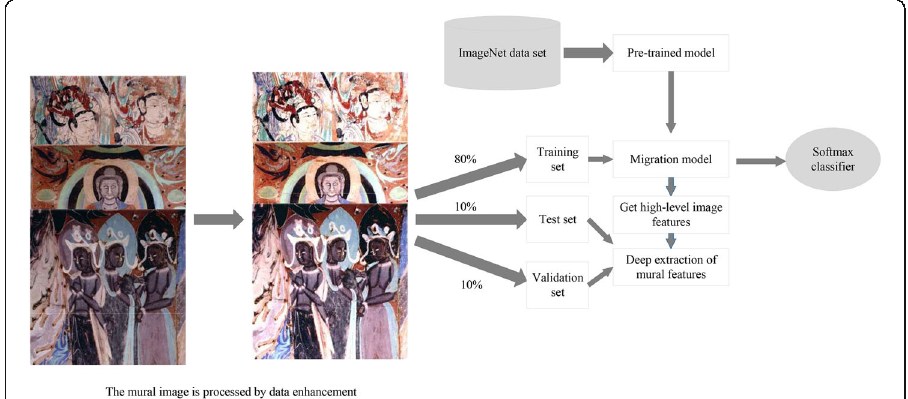
Fig. 3 Framework of the Inception-v3 model fused with transfer learning for ancient mural